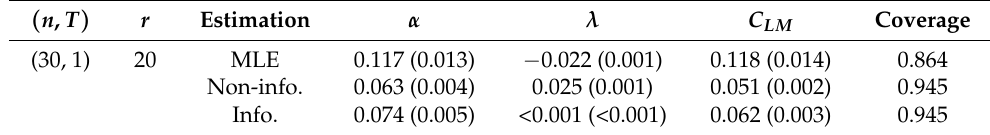
Table 1. The rBias and rMSE (in parentheses) for ( α , λ ) = ( 2, 1 ) and L = 0.05. ( n , T